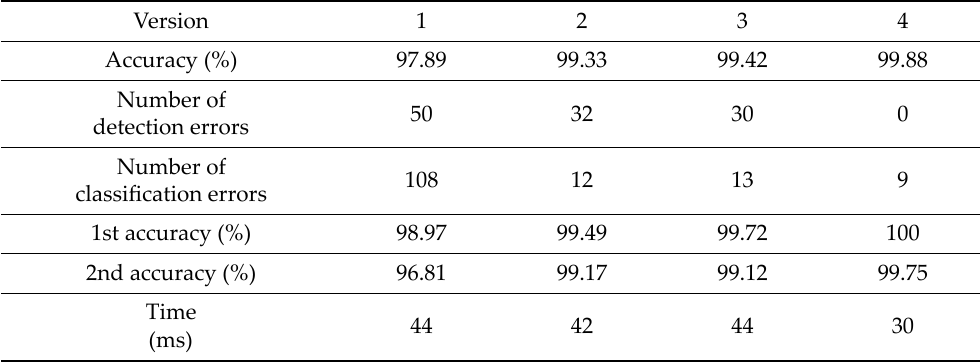
Table 2. Model performance comparison of different architecture versions.